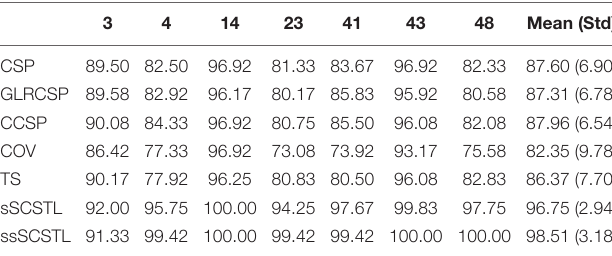
TABLE 1 | Average classification accuracies of supervised and semi-supervised algorithms for good subjects on dataset MI1 ( R l = 40%).